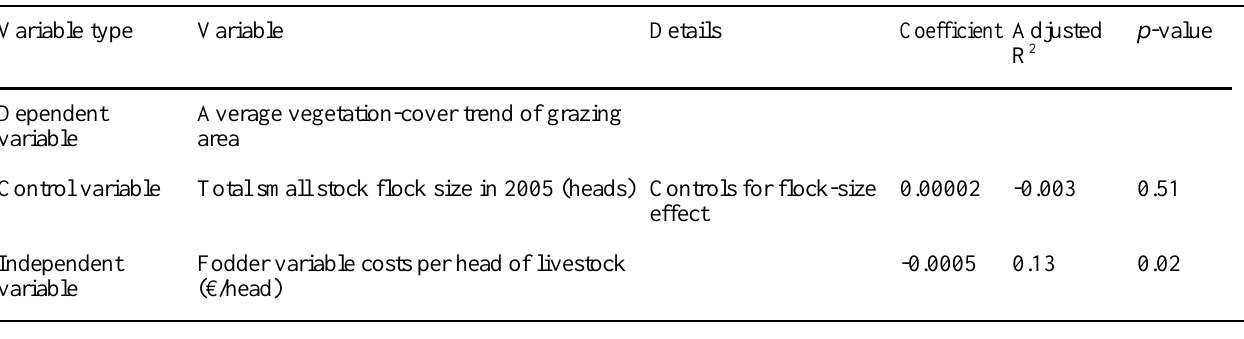
Table 6. Linear regression results for stock-breeding intensification as explanatory variable for average vegetation-cover trend of grazing areas ( n =